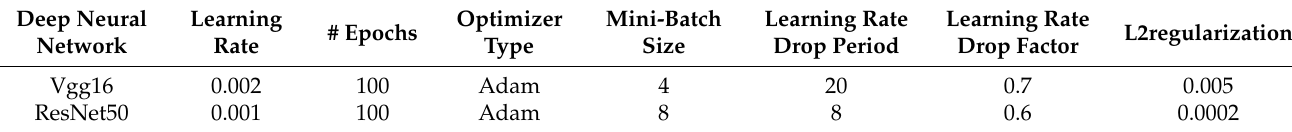
Table 3. Hyper-parameters used for training and monitoring the Vgg16 and ResNet50 to classify rapeseed crop images. Deep Neural